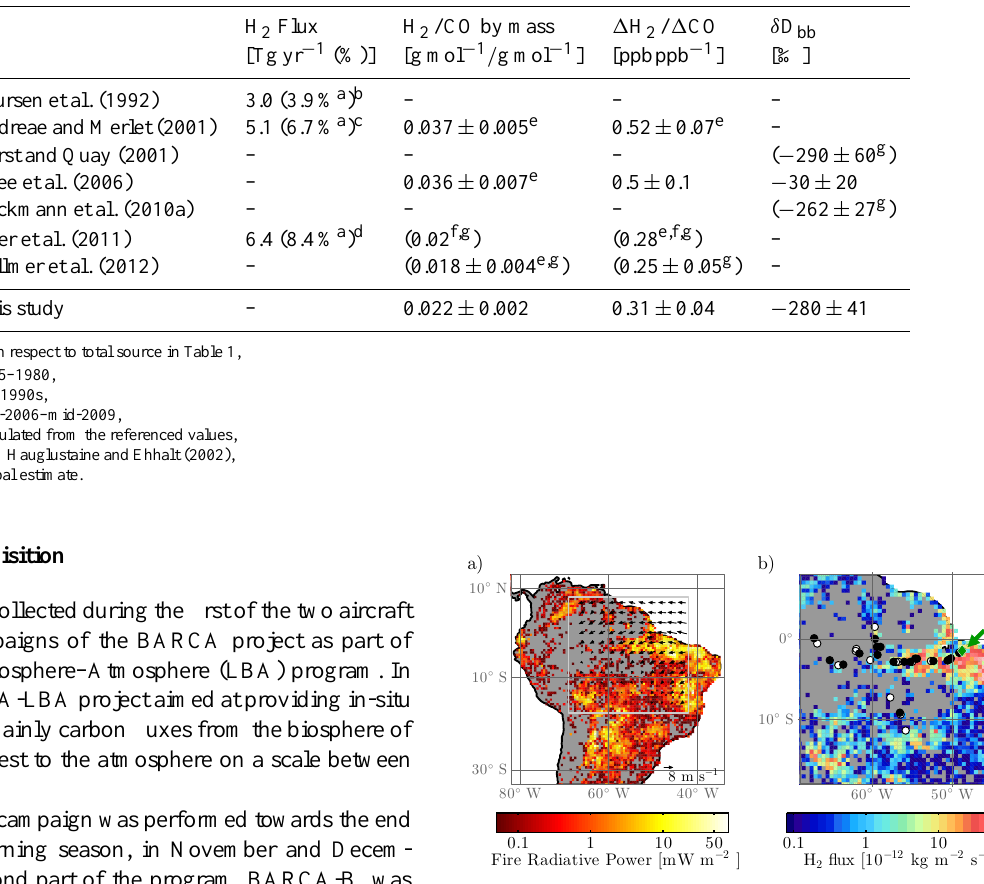
Fig. 1. Biomass-burning sources in the sampling area from Novem- ber to December 2008. (a) Mean GFASv1.0 fire radiative power from wildfires (Kaiser et al., 2012) and ERA-Interim reanalysis wind vectors on the 800hPa level (Dee et al., 2011). (b) Enlarge- ment of the box in (a). Mean GFASv1.0 scaled H 2 emissions from biomass burning (Kaiser et al., 2012) and BARCA-A sample sites (circles) used in this study (black: above 1100ma.s.l.; white: below 1100ma.s.l.; and green (highlighted by the arrow): highly contam- inated sample in Figs. 2 and 3).